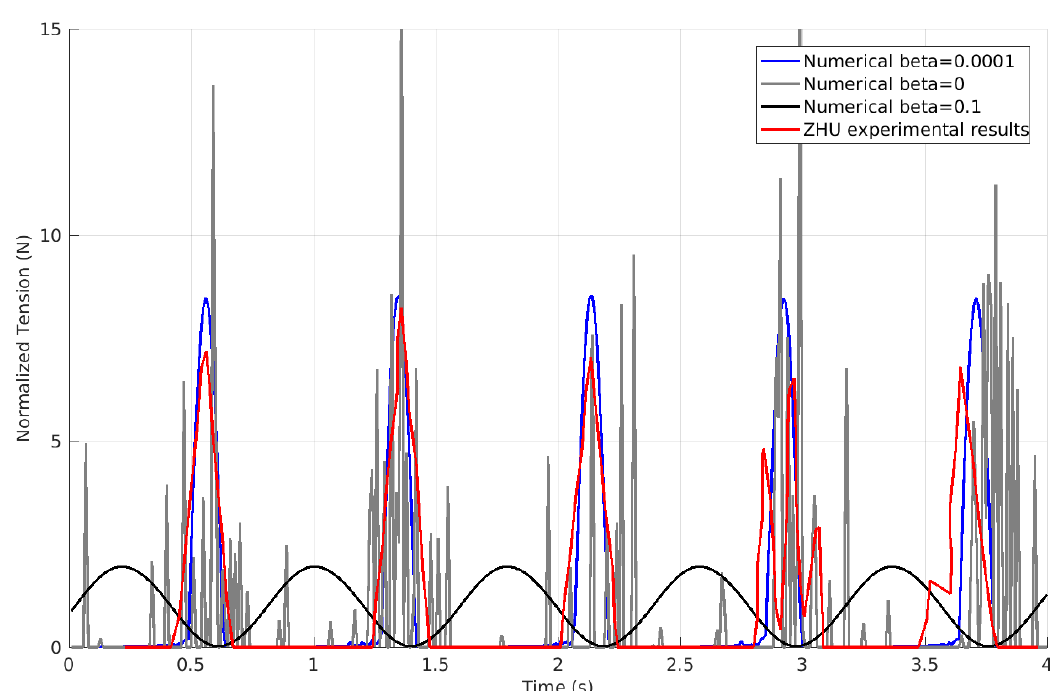
Figure 5. Optimal validation with Zhu’s high-frequency experiment results.